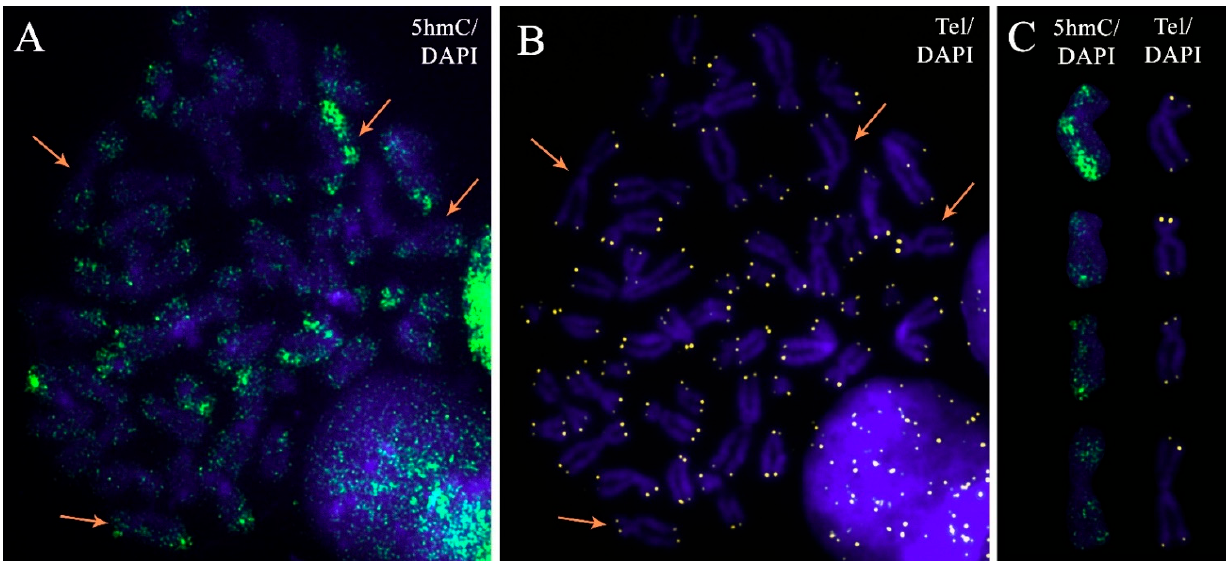
Figure 7. The metaphase plate from a chorionic cytotrophoblast cell after immunocytochemical detection of 5-hydroxymethylcytosine (5hmC) ( A ) and detection of telomeric regions through fluorescent in situ hybridisation (FISH) with telomeric DNA probes ( B ). The chromosomes were stained with DAPI. The arrows show chromosomes represented on karyogram ( C ): those demonstrating the asymmetrical pattern of hydroxymethylation with 5hmC in only one sister chromatid—hemihydroxymethylation.